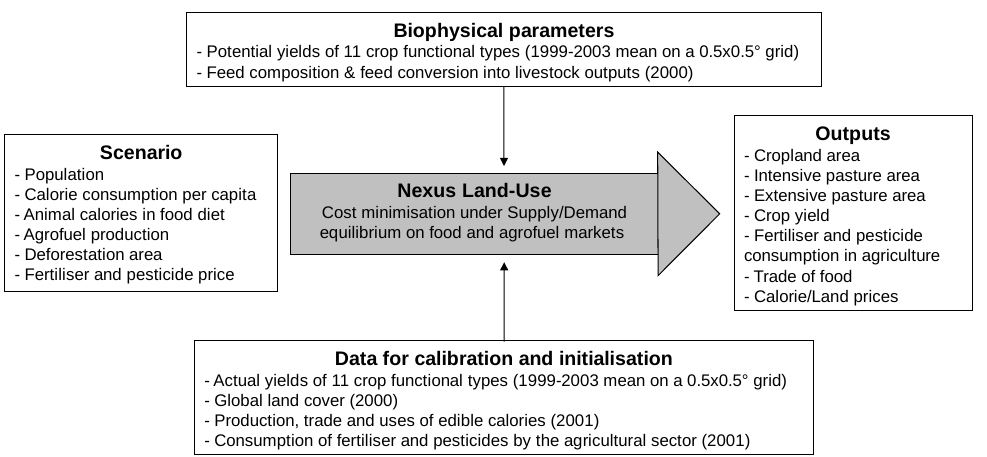
Fig. 1. Description of the modelling system. Fertiliser and pesticide consumption includes also other consumption of chemical and mineral